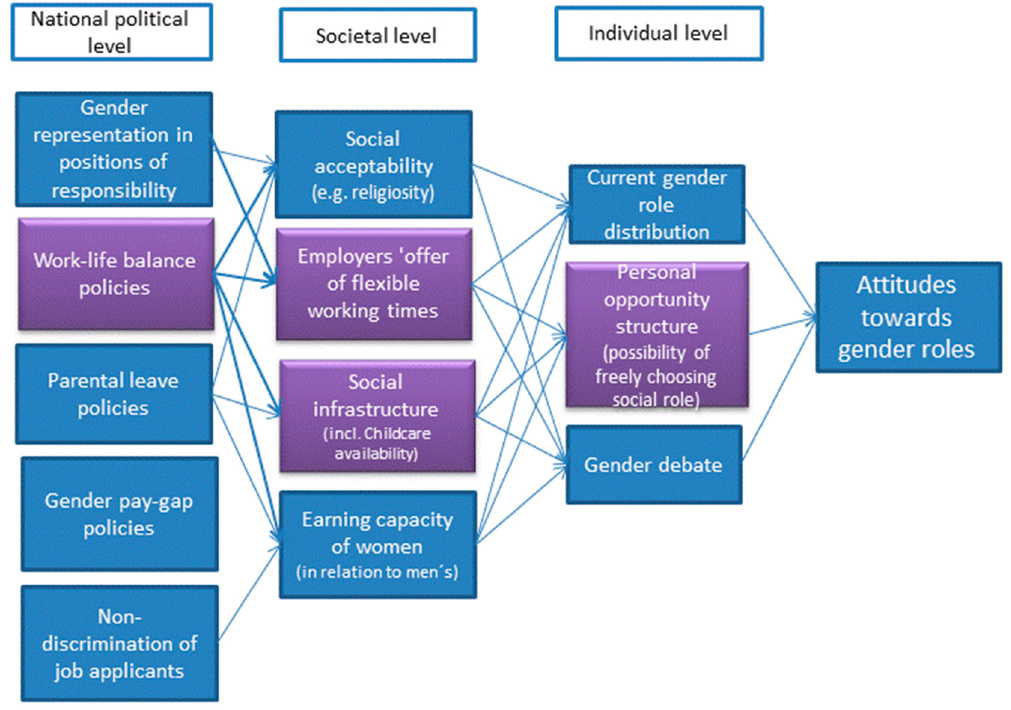
Figure 2. The relation between gender mainstreaming and individual gender-role attitudes. Note: The causal pathway that we aim to describe in this study is marked in violet.